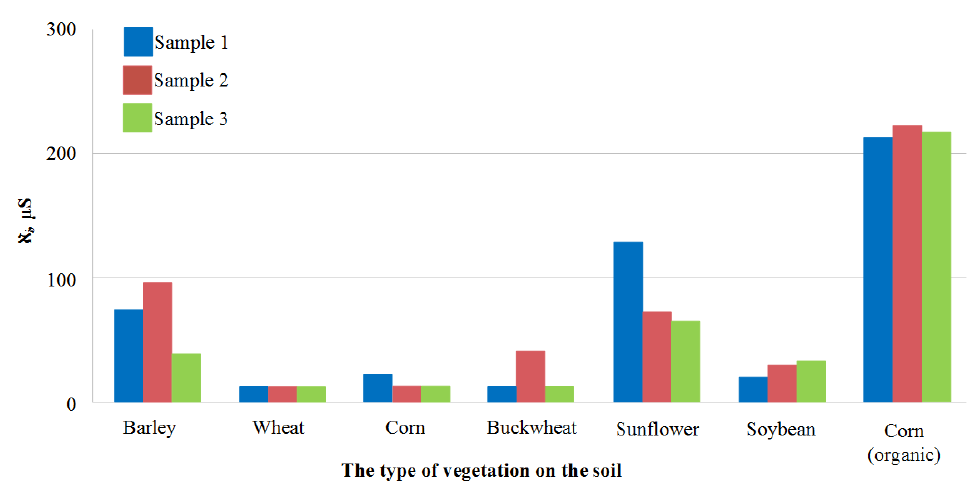
Fig. 2. Data on electrical conductivity of the studied samples of agricultural soils in the fields where different crops grew. It was found that the average S r value for all measurements does not exceed 5 %. As can be seen from the obtained results (Fig. 2), there is a significant variation in the values of electrical conductivities in agricultural fields sown with different